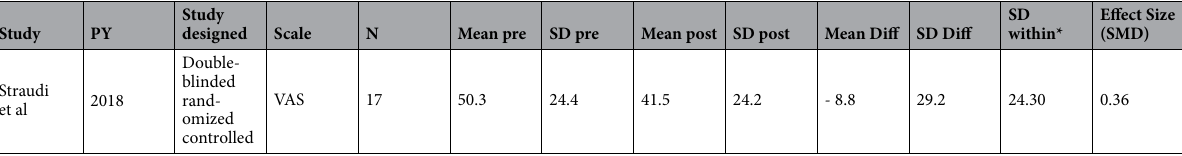
Table 11. Pain. Sham. *the correlation, r = 0.28, between pre-post data were extracted from the variance of the difference. PY = Publication Year SD = Standard Deviation. SMD = Standardized Mean Difference. SE = Standard Error.